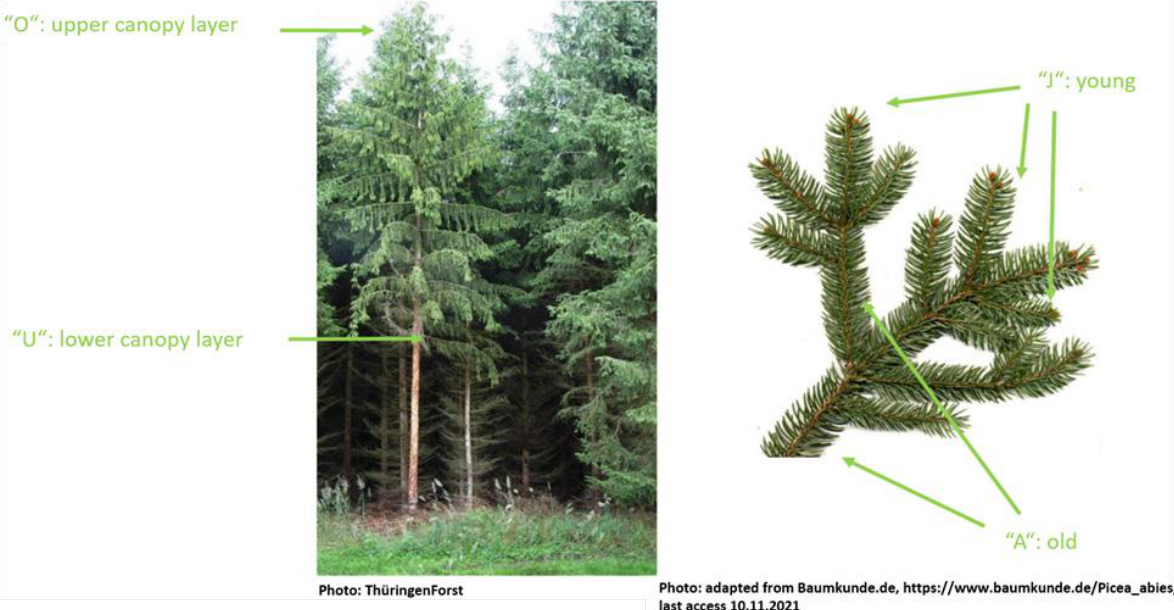
Figure 3. Position of the different samples on an exemplary tree: “OA” means the needles samples have been taken from the upper canopy layer and are situated on the older branch parts, “OJ” that the needle samples have been taken from the upper canopy on the younger branch parts, “UA” from the lower canopy parts on older branch parts, and “UJ” from the lower canopy on younger branch parts.